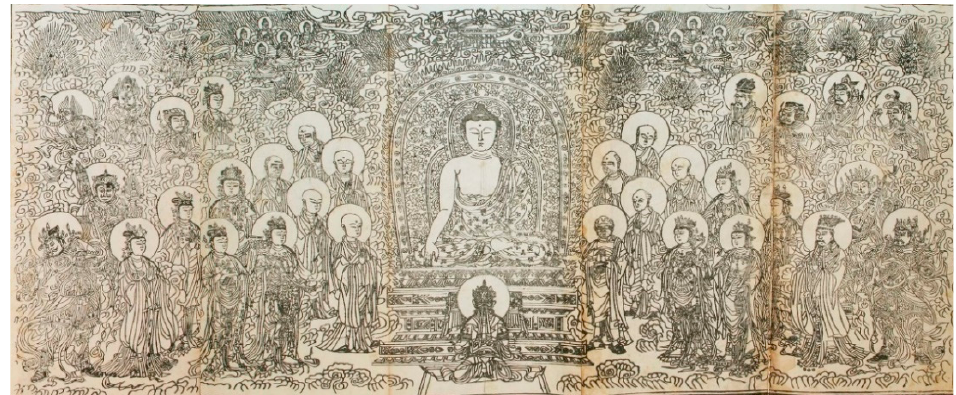
Figure 8. Avatamsaka Sutra , Ming dynasty, private collection. Photo by the author.